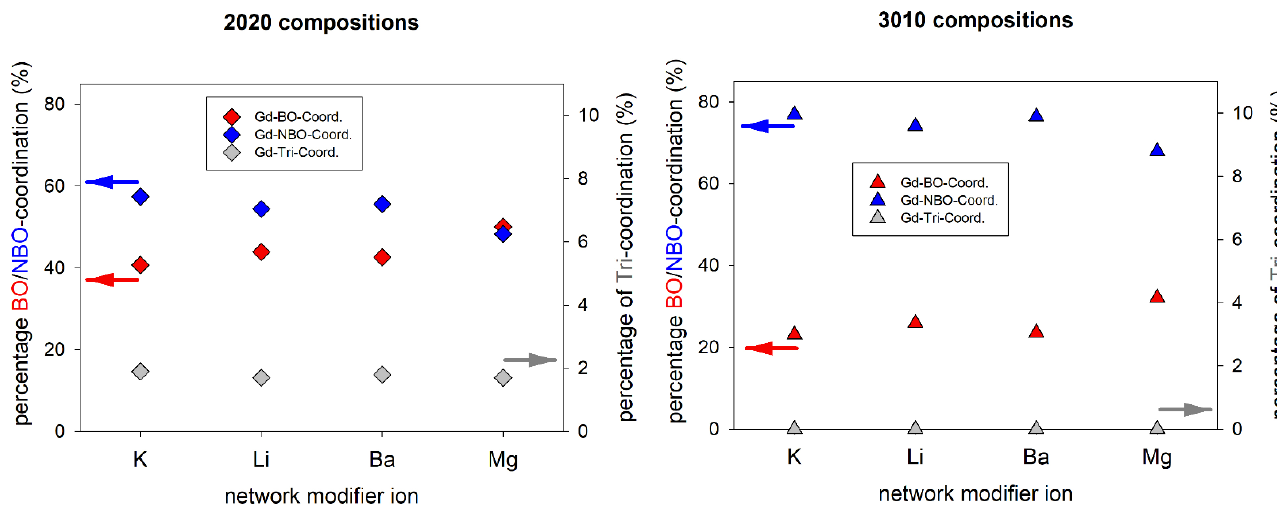
Figure 8. Gd-oxygen coordination fractions for metaluminous ( left ) and peralkaline ( right ) alkali and alkaline earth aluminosilicate glasses. Values for Ba and Mg-containing glasses are taken from [26].